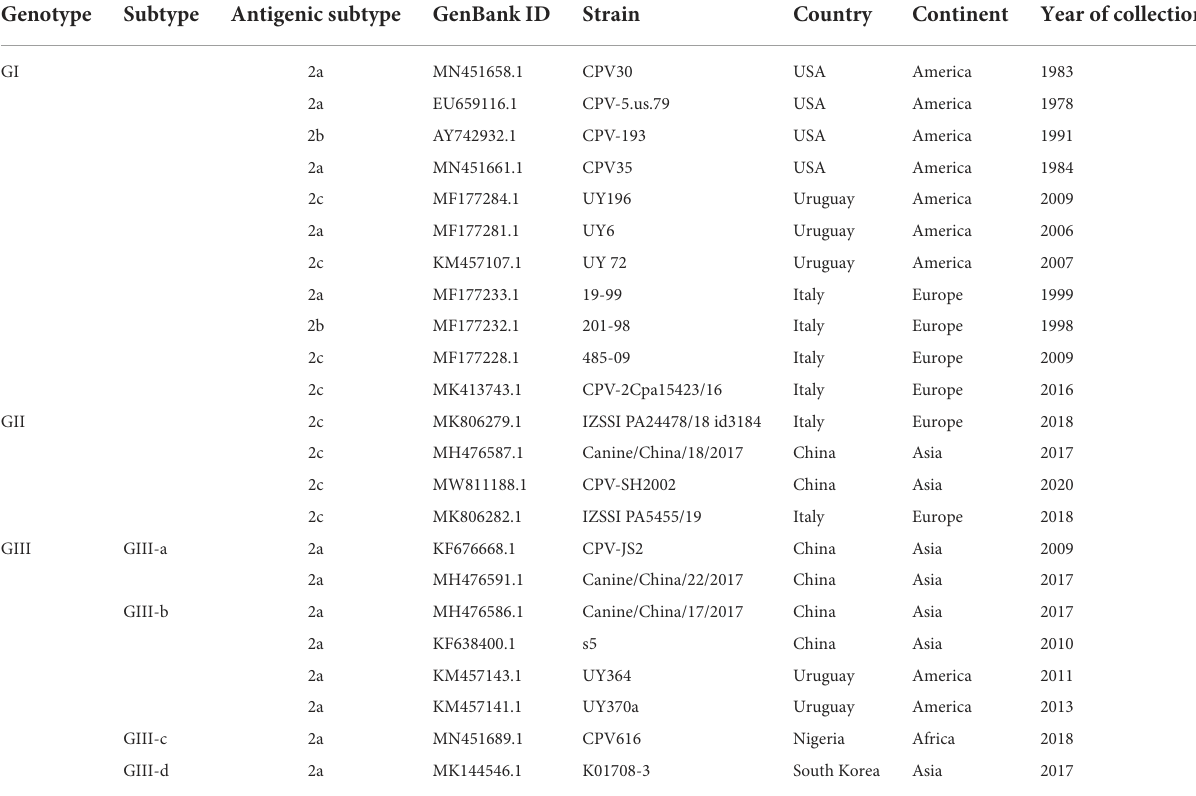
TABLE 1 Reference sequences of CPV-2 genotypes and